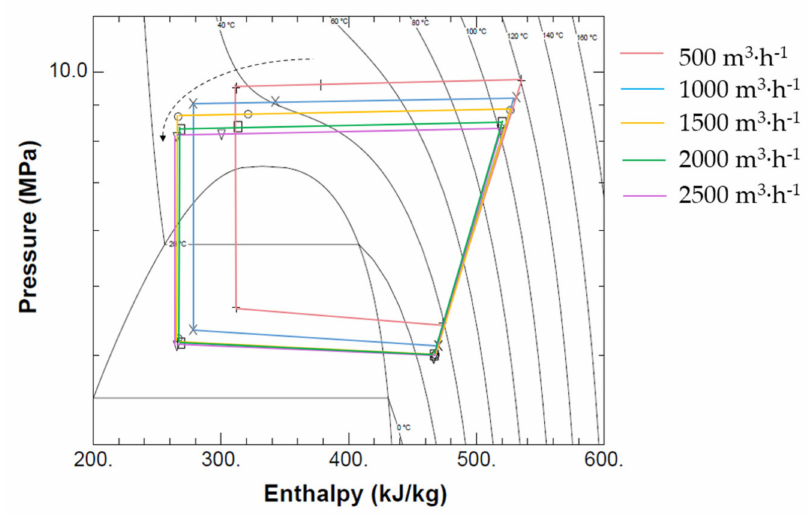
Figure 8. P–h diagrams of the investigated air conditioning system at gas cooler air volume flow rates between 1000 m 3 · h − 1 and 3500 m 3 · h − 1